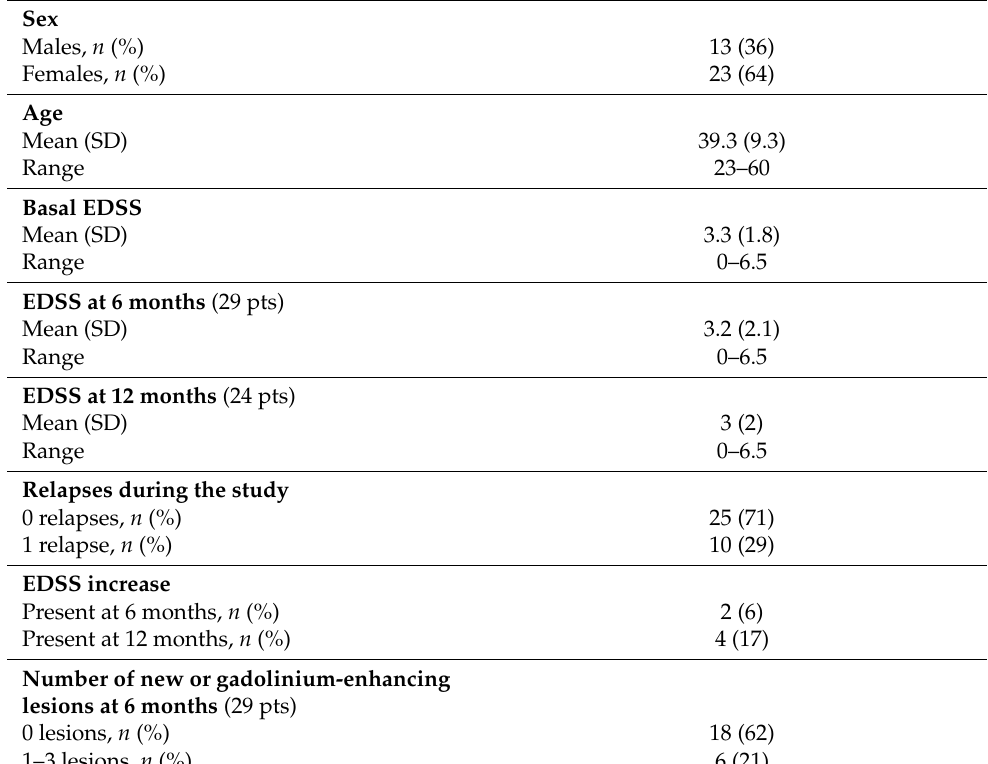
Table 1. Patient